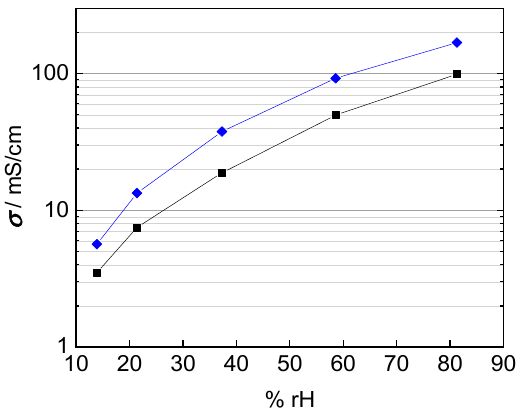
10 of 16 Figure 9. Calculated conductivity of Nafion 117 at 100 °C with ( a ) black: thickness of dry membrane; blue: swollen thickness; red: interpolated thickness with respect to humidity; and ( b ) black: interpolated thickness with respect to humidity and mesh indentation; red: interpolated thickness with respect to humidity. In fact, the calculated conductivity values are lower than those reported in literature, which vary from 80 mS/cm up to 140 mS/cm at 100 °C and 100% rh [1,2,20,22,25]. The conductivities shown in Figure 9 were calculated with a conducted area between membrane and electrodes corresponding to the enclosed area of edge length, i.e., A = a × b . The mismatch in conductivity and the obvious mesh indentations let us reconsider the influence of the contact area of the platinum mesh, as the open mesh surface is 65%. Regarding Equation (1) for conductivity calculation, the open mesh surface had to be